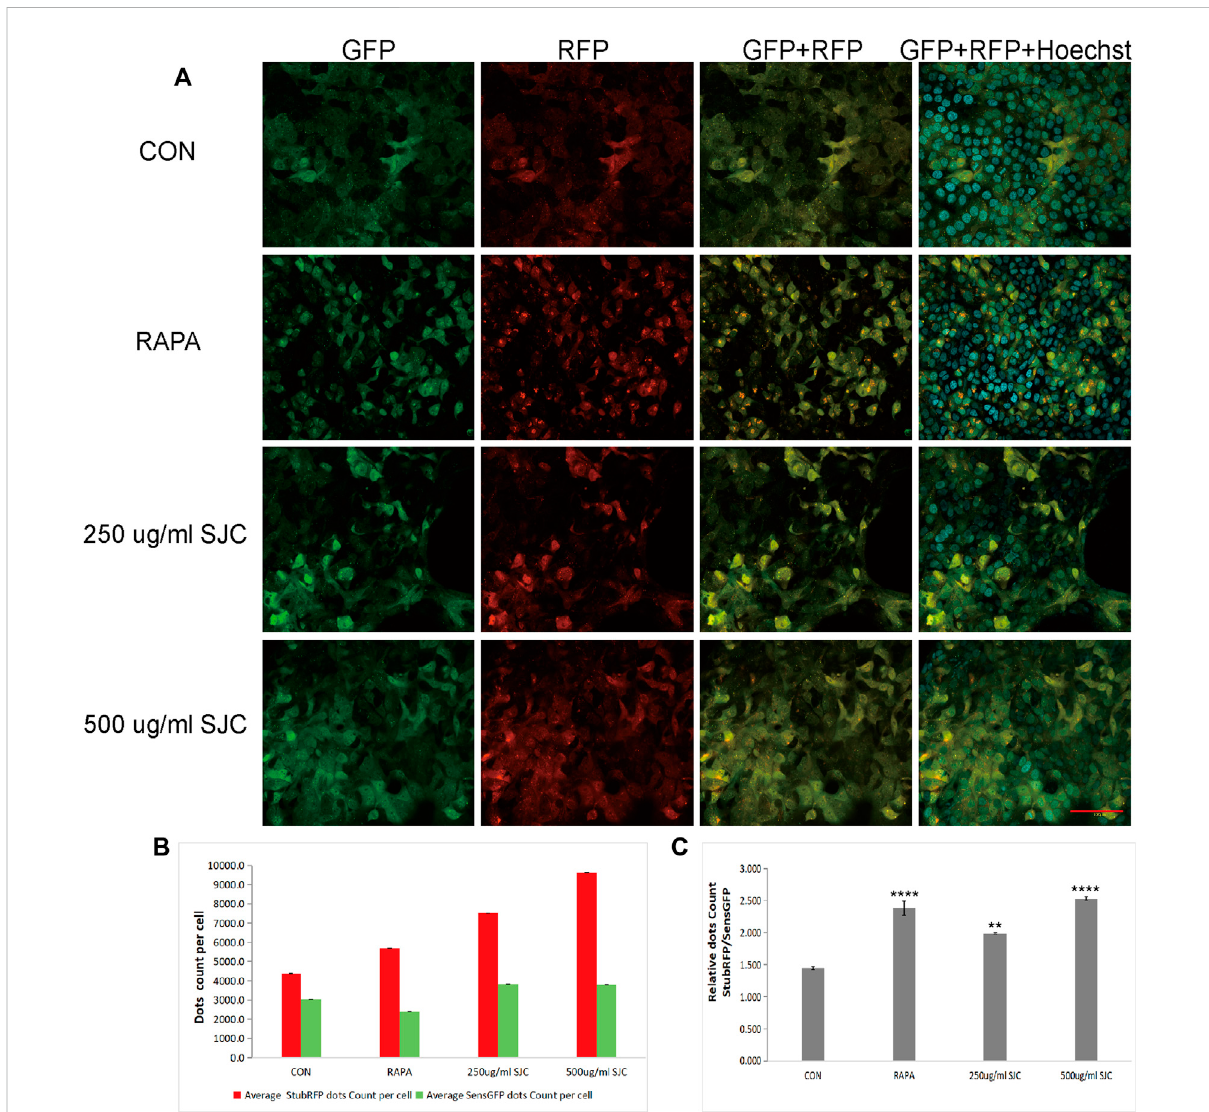
FIGURE 7 Esophageal carcinoma cells with stable expression of sensGFP-stubRFP-LC3 protein were established and observed under a confocal laser microscope. (A) Cell morphology and fl uorescence expression after treatment by Rapa and SJC with different concentrations observed by confocal laser microscope. (B) Histogram of StubRFP and SensGFP expression of LC3 in each group. (C) Histogram of StubRFP/SensGFP ratios. Compared with CON, * p < 0.05, ** p < 0.01, *** p < 0.001, **** p <